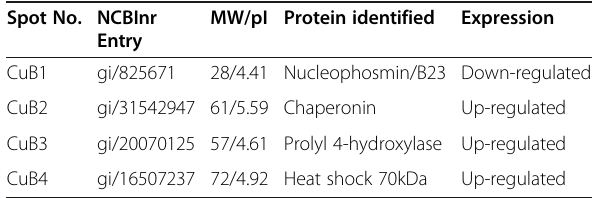
Table 1 LC-MS/MS identification of the peptide spots